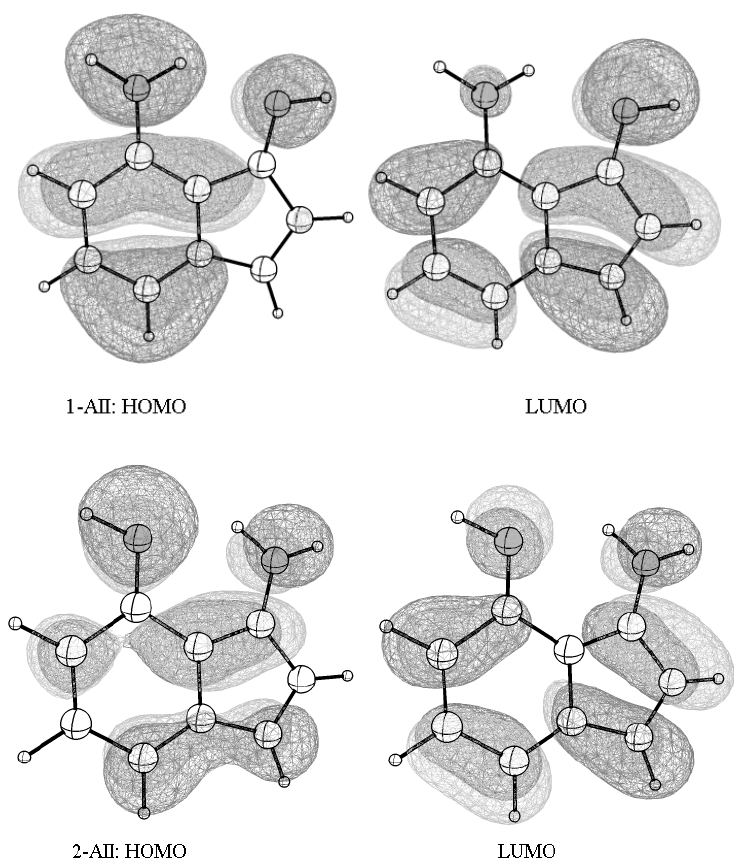
Figure 6. The frontier orbitals—the highest occupied molecular orbital (HOMO) and the lowest unoccupied molecular orbital (LUMO)—spreading over the entire molecular skeleton allow an π - π interaction and intra-molecular electrons flow in the two tautomerism efficient π - π interaction and intra-molecular electrons flow in the two tautomerism states.